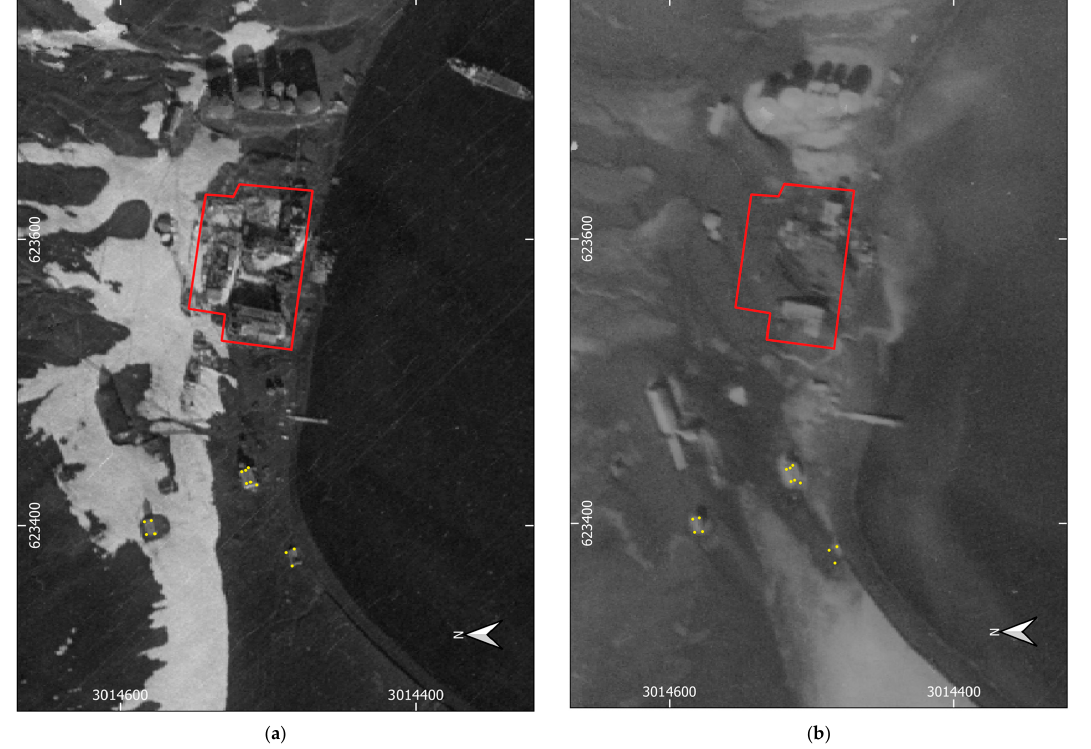
Figure 7. British base in 1956 ( a ) and 1968 ( b ). Ground control points are coloured yellow, coinciding with the corresponding features, in WGS84–UTM20S, and red polygon delimiting the main